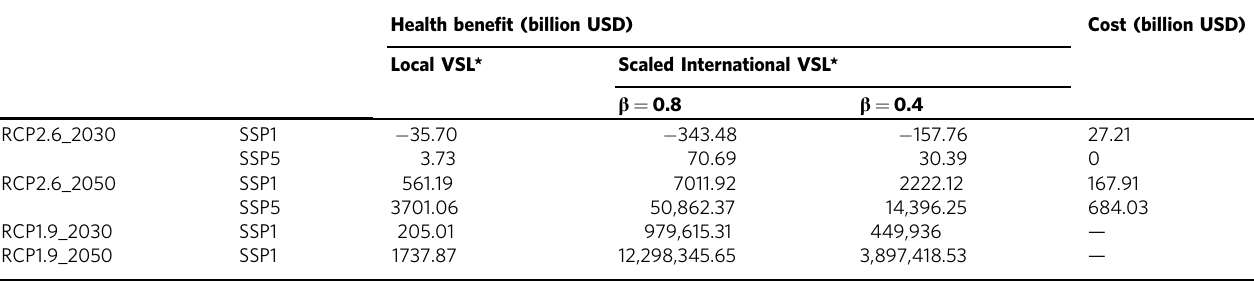
Table 2 Comparison of costs and bene fi ts of climate